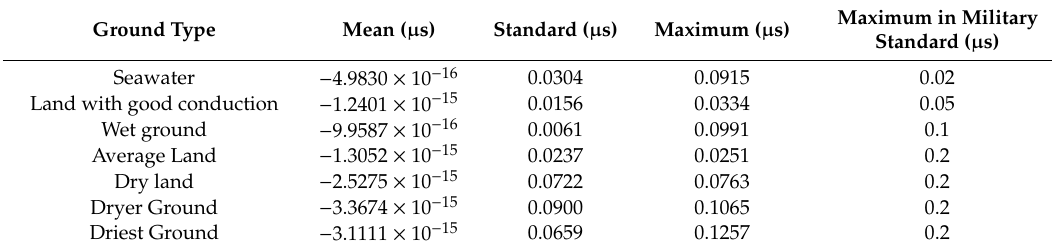
Table 2. The fitting analysis of secondary delay (100 km < d